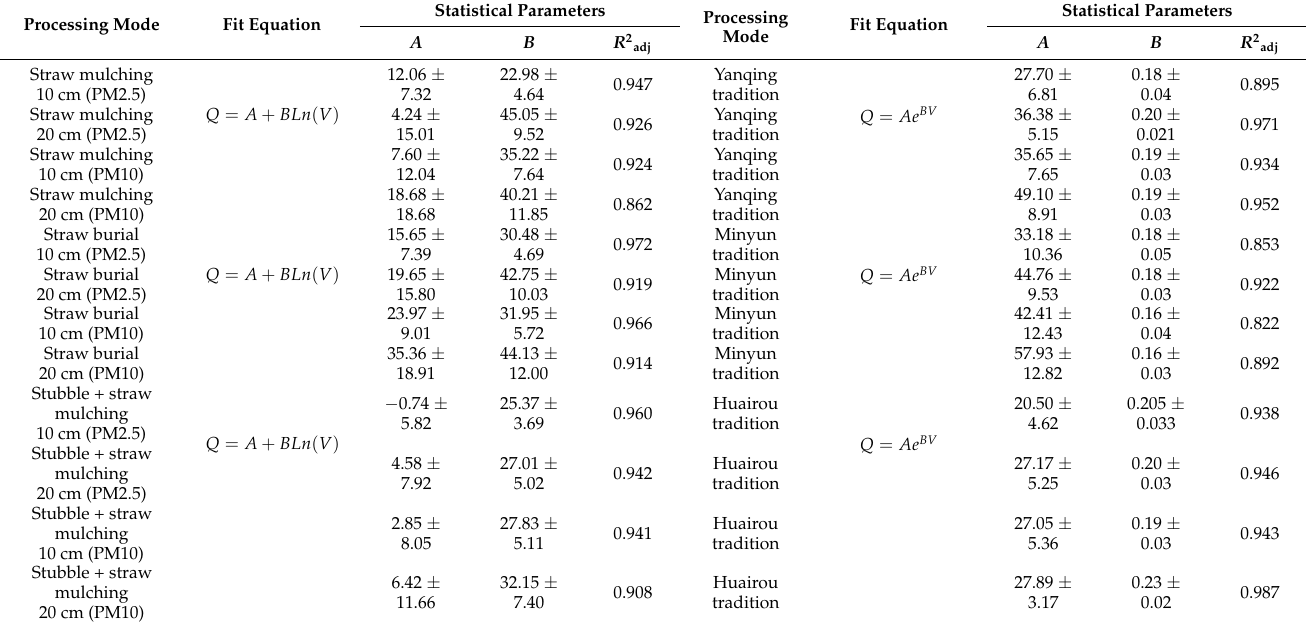
Table 6. Fitting equation of farmland PM2.5 and PM10 release under different surface wind